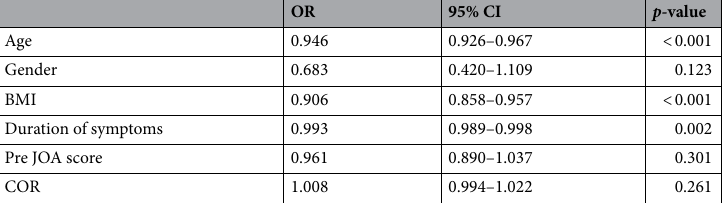
Table 8. Factors affecting MCID success. MCID: minimal clinically important difference; BMI: body mass index; JOA: Japanese Orthopaedic Association; COR: canal occupying ratio; OR: odds ratio; CI: confidence